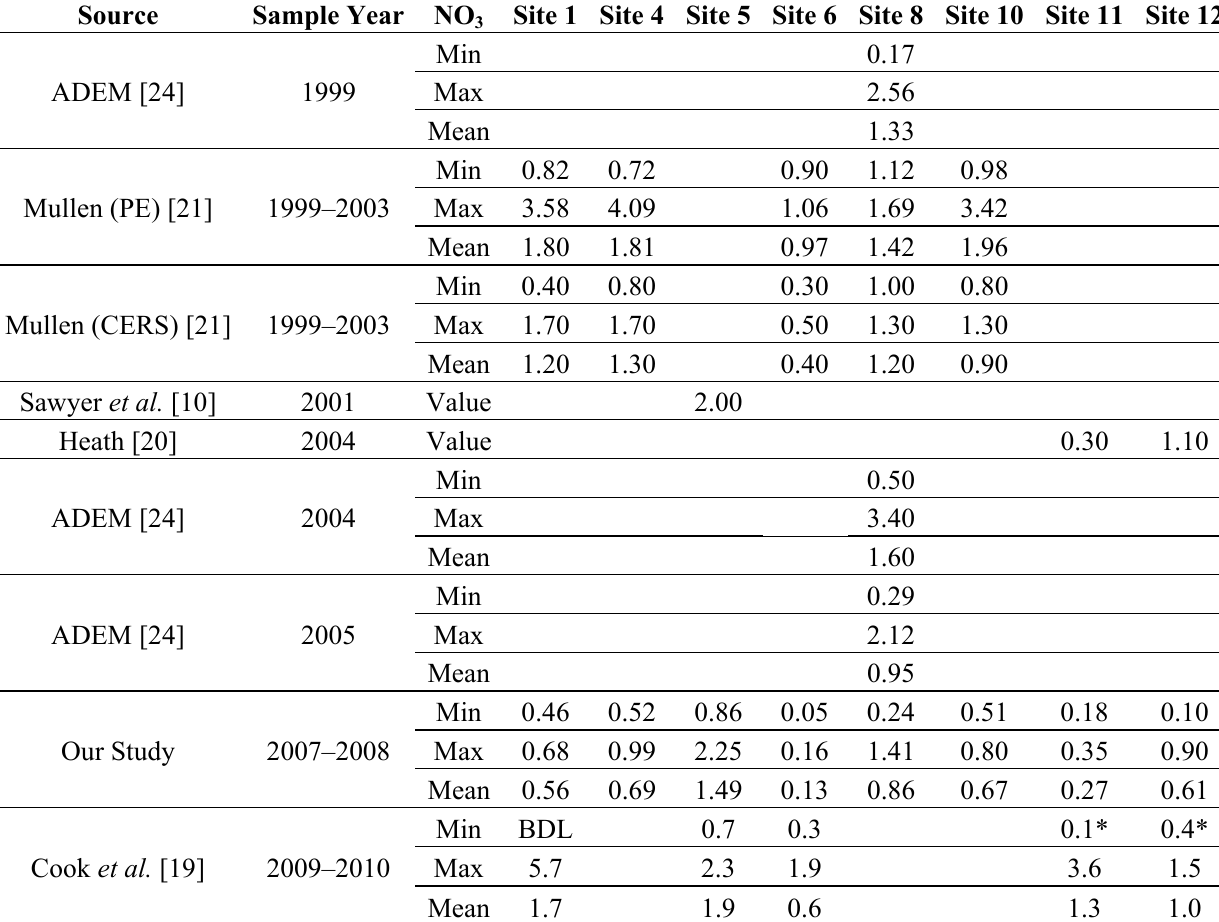
Table 4. Minimum, maximum, and mean (if available) of nitrate (NO concentrations from historical sources in chronological sampling order, with coinciding sites, along with our data.